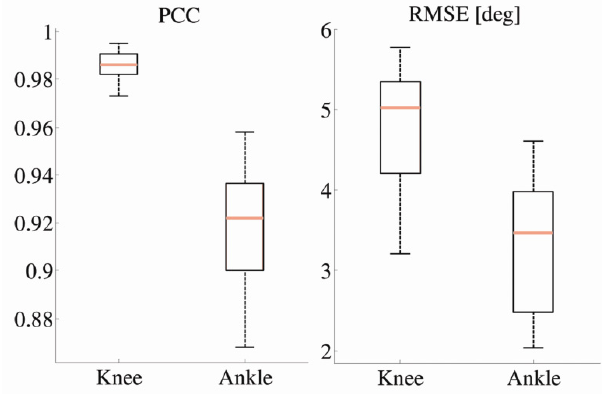
Figure 9. Boxplots presenting comparison between joint angles (for knee and ankle angles) calculated from accelerometers and goniometers. Left: Pearson’s correlation coefficient (PCC). Right: root-mean-square error